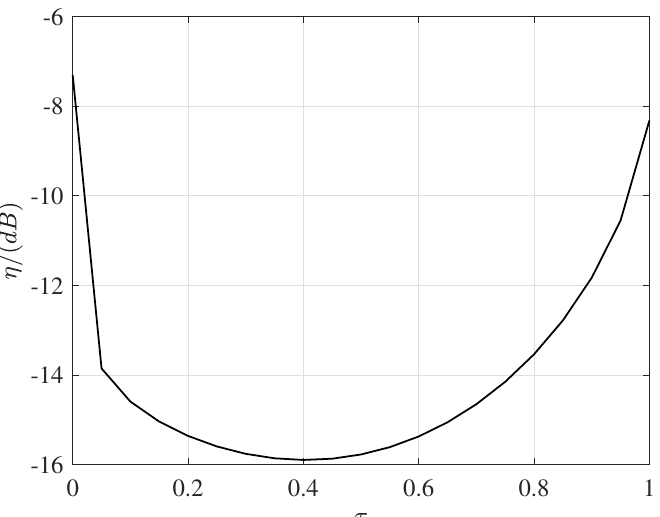
Figure 6. The NMSE of the reproduced sound pressure at uncontrolled points. The reverberation time RT 60 = 200 ms and the control filter length J = 400.